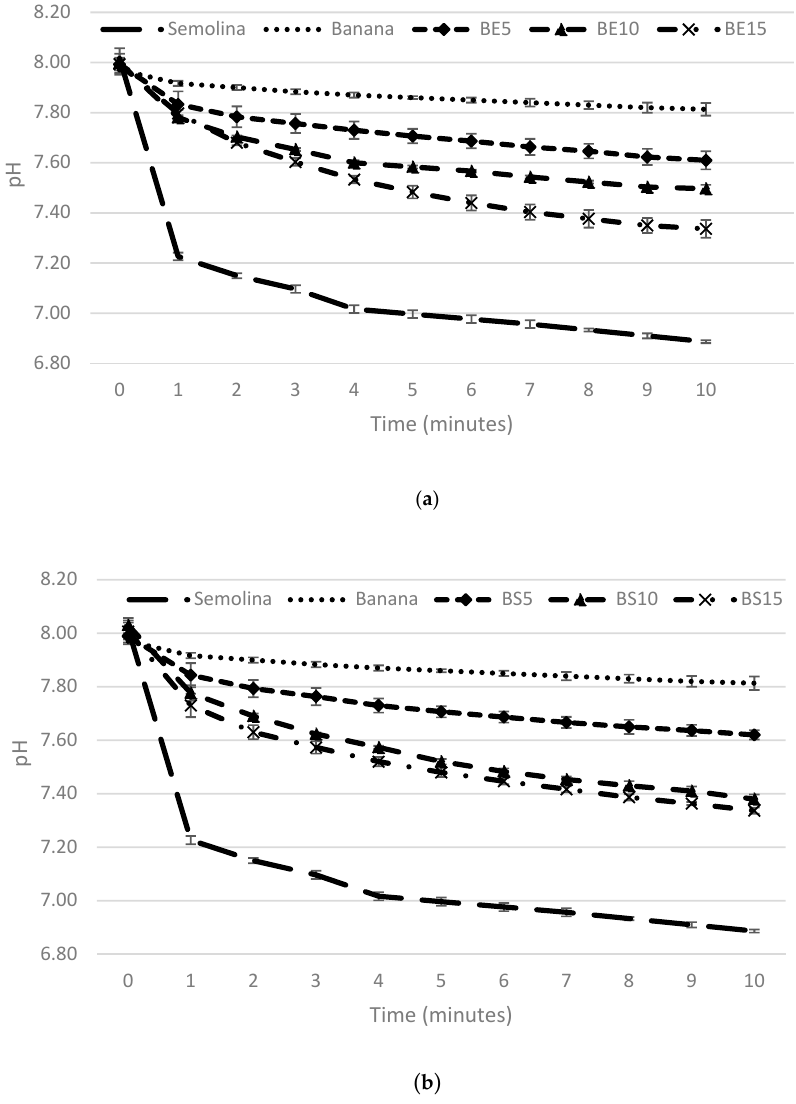
Figure 2. The pH change over time during multi-enzymes (trypsin, chymotrypsin and protease) incubation of semolina, banana pasta and banana pasta with protein addition: ( a ) BE5, BE10, BE15 = Banana pasta with 5, 10, 15 g egg white protein/100 g banana flour; ( b ) BS5, BS10, BS15 = Banana pasta with 15 g soy protein/100 g banana flour.